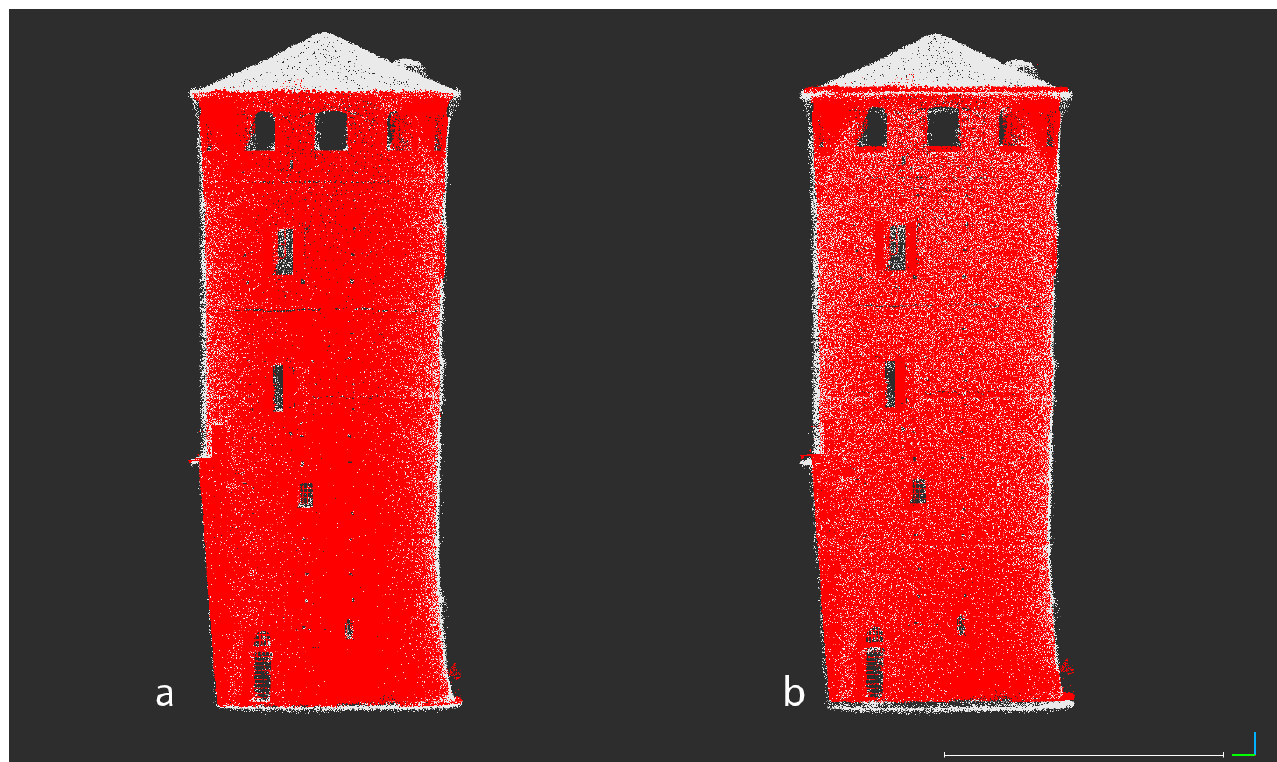
Figure 13. ICP registration and alignment related to L1 data (white—aligned) and SX10 (red—static reference): ( a ) before the alignment; ( b ) after the alignment.